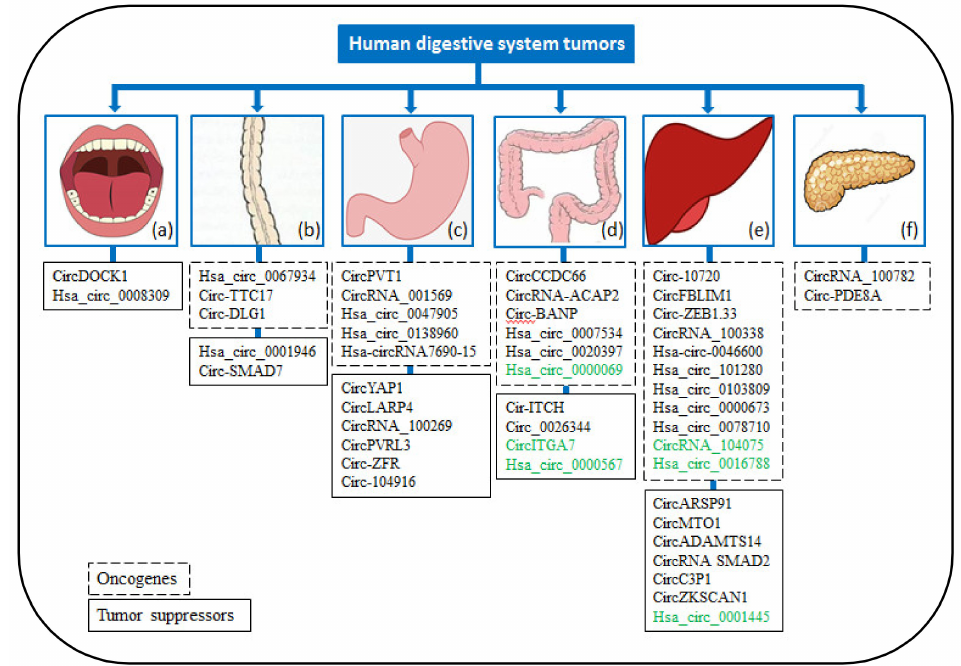
Figure 2. Dysregulated circRNAs act as oncogenes or tumour suppressors and have diagnostic value in digestive system cancers. ( a ) Oral cavity, ( b ) oesophagus, ( c ) stomach, ( d ) colorectum, ( e ) liver, and ( f ) pancreas. Green indicates circRNAs with potential diagnostic value in digestive system